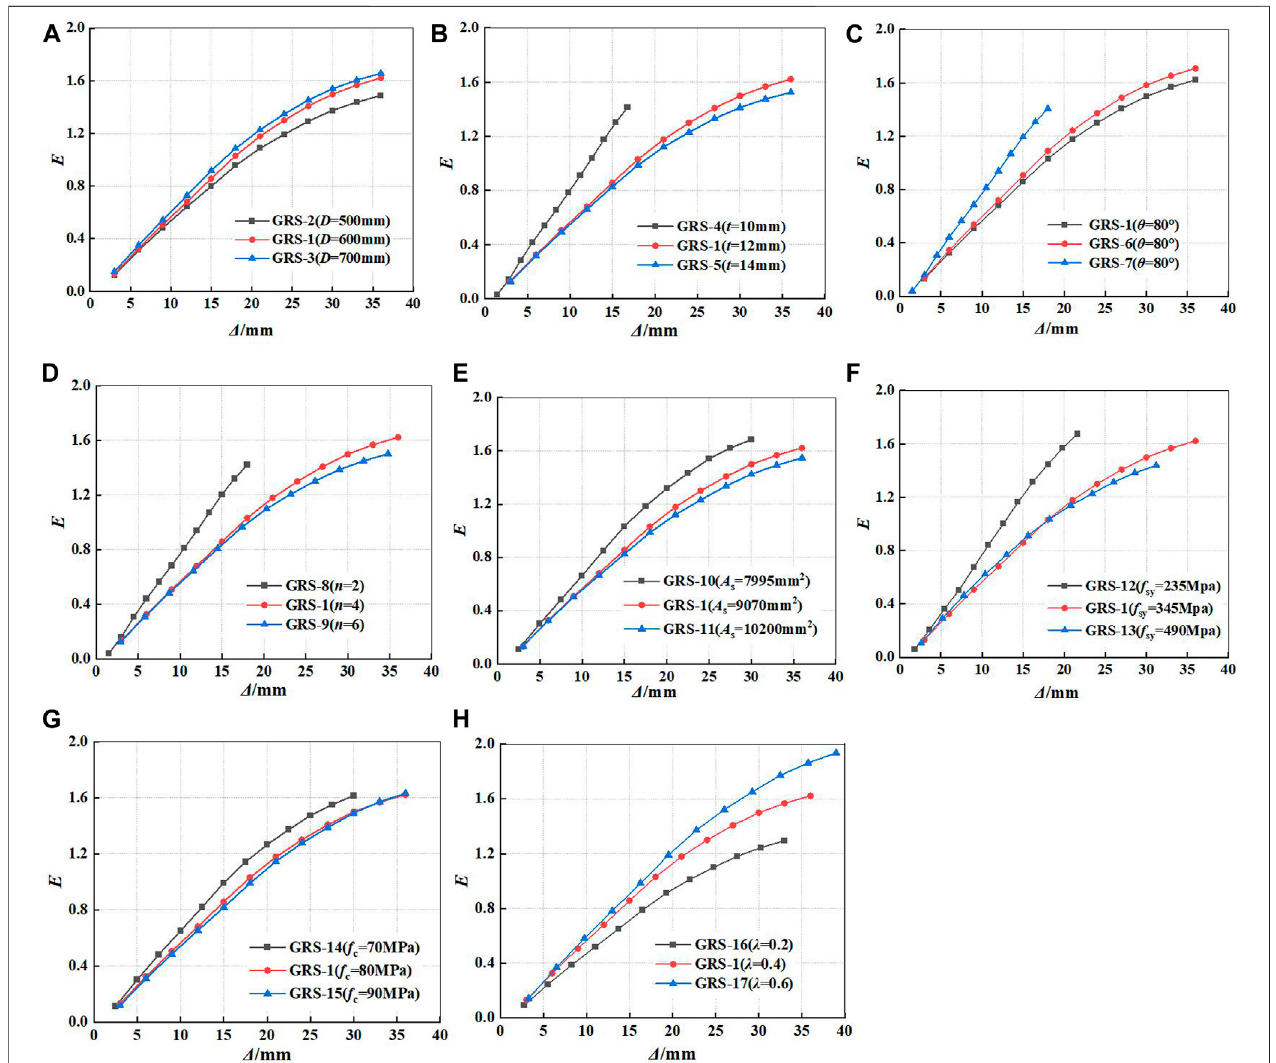
FIGURE 13 | Comparisons of energy dissipation capacity for GRS columns: (A) different diameters of GFRP tube; (B) different thicknesses of GFRP tube; (C) different fi ber winding angles; (D) different numbers of fi ber winding layers; (E) different areas of encased steel; (F) different strengths of encased steel; (G) different compressive strengths of RPC; and (H) different axial compression ratios.